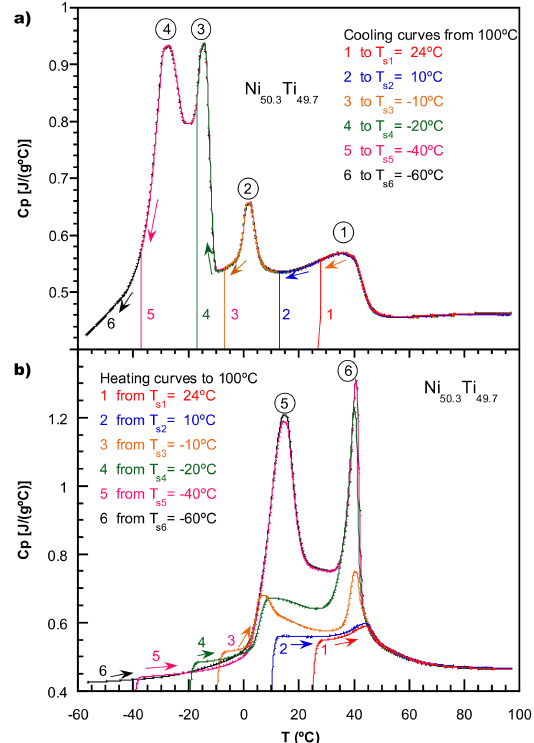
Figure 3. Description of the various thermal cooling ( a ) and heating ( b ) cycles performed on Ni 50.3 Ti 49.7 for the study of the six MT stages. The vertical lines indicate the approximate temperature stops ( T s